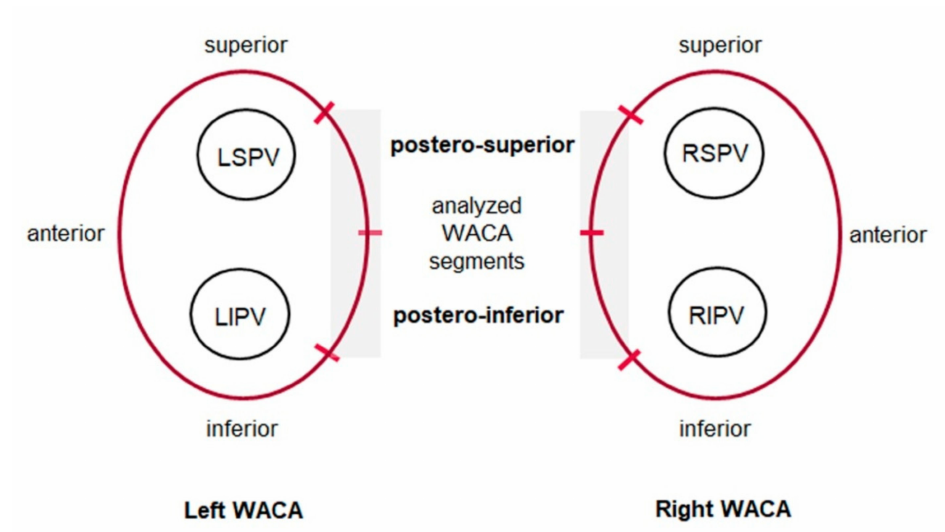
Figure 2. Schematic depiction of the investigated ablation sites at the posterior segments of the wide antral circumferential ablation line around the pulmonary veins. Contact force parameters were analyzed at four pre-defined sites (shaded in grey) of the WACA line (red) that are in close anatomic proximity to the esophagus: the postero-superior and postero-inferior segments around the left and right pulmonary veins. LSPV indicates left superior pulmonary vein; LIPV, left inferior PV; RSPV, right superior PV; RIPV, right inferior PV; and WACA, wide antral circumferential